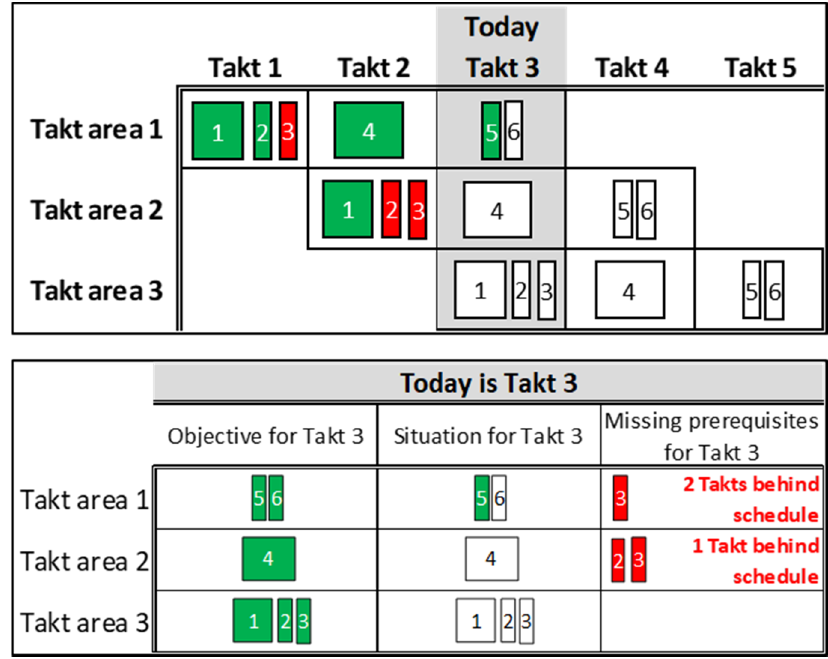
Figure 9. An example of illustrating late work packages and work steps in takt production.